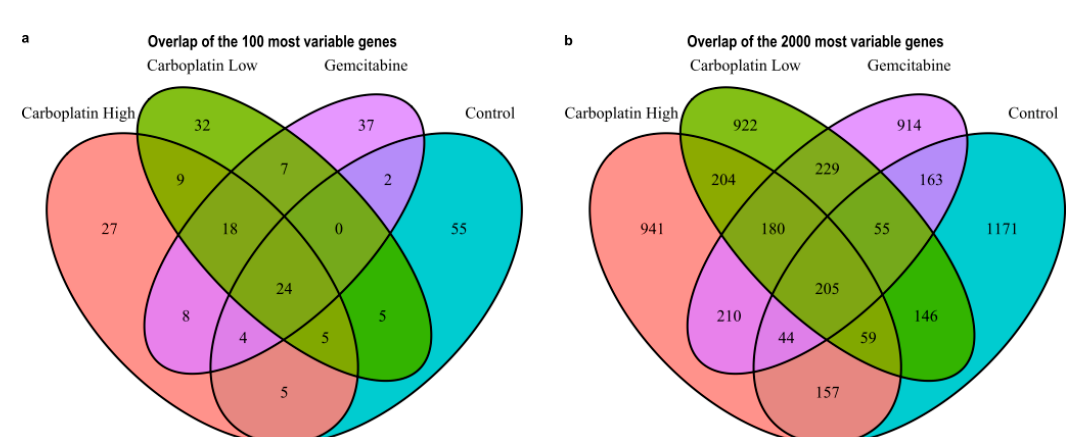
Figure 2. Depicts the most variable genes for ( a ) Carboplatin High, ( b ) Carboplatin Low, ( c ) Gemcitabine, and ( d ) Control. The ten genes with the highest standardized variance are written out for each sample.